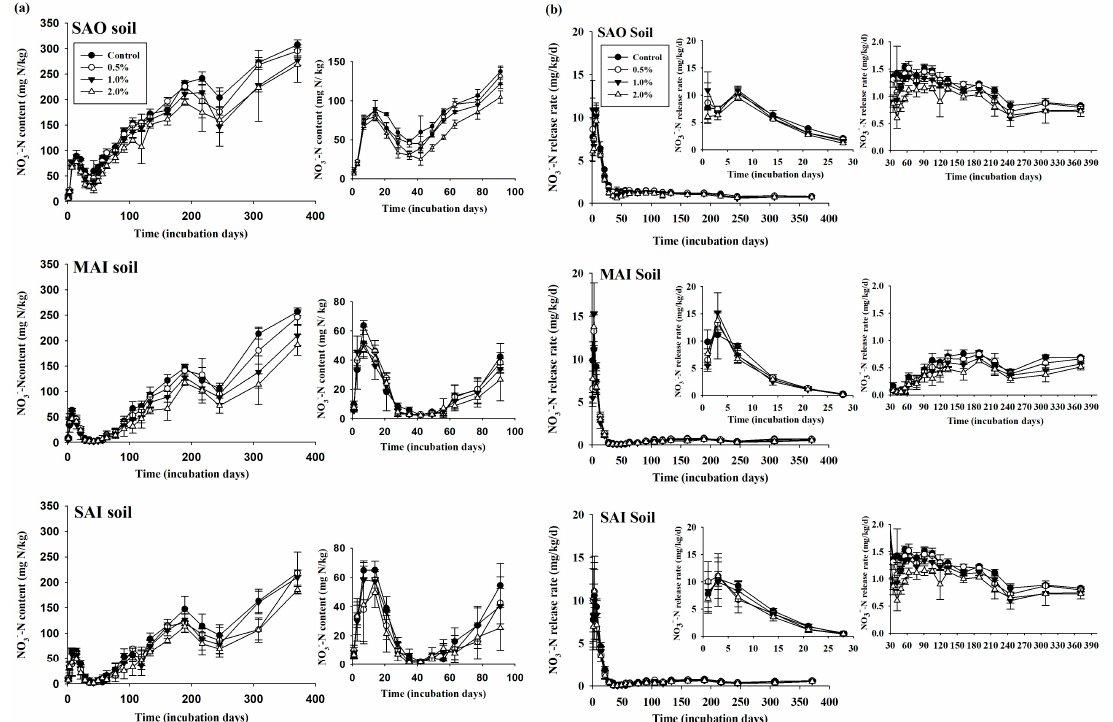
Figure 2. E ff ects of biochar additions on ( a ) NO 3 − -N content and ( b ) NO 3 − -N release rate. For each incubation time, release rate was calculated as the amount of release divided by the incubation time. The data are mean value ( n = 5), and vertical bars represent standard deviations (SDs) of the